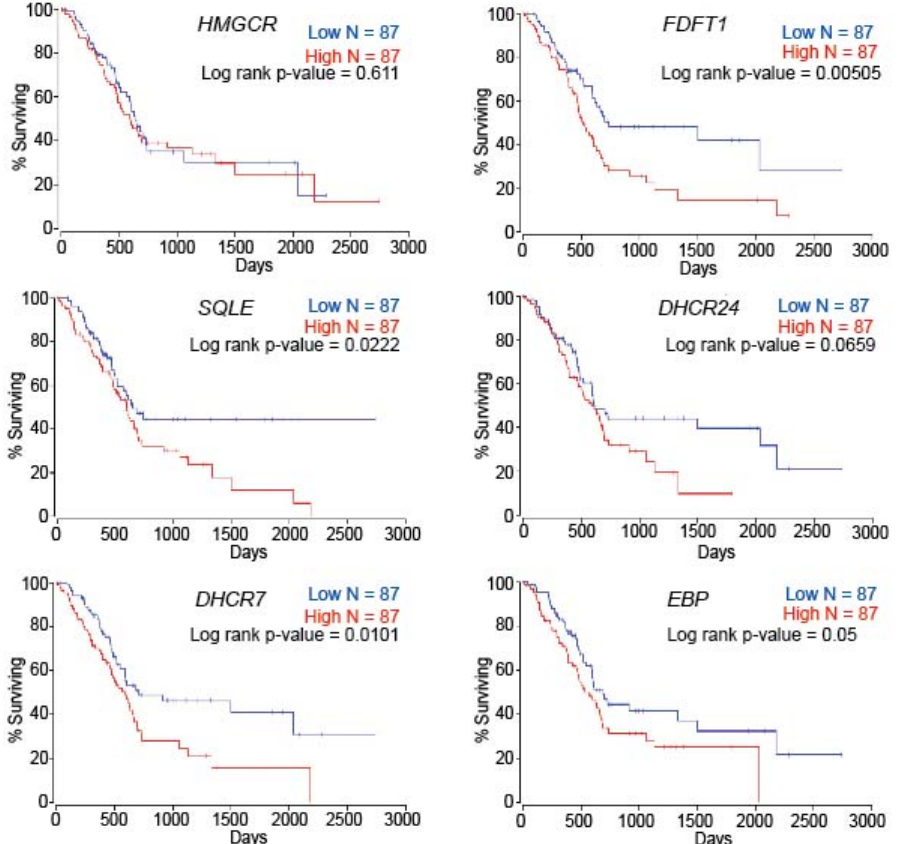
Figure 6. Genes involved in cholesterol synthesis affect patient survival in PDAC. Kaplan–Meier survival curves reflecting the impact of cholesterol metabolic genes expression on patient survival in PDAC.